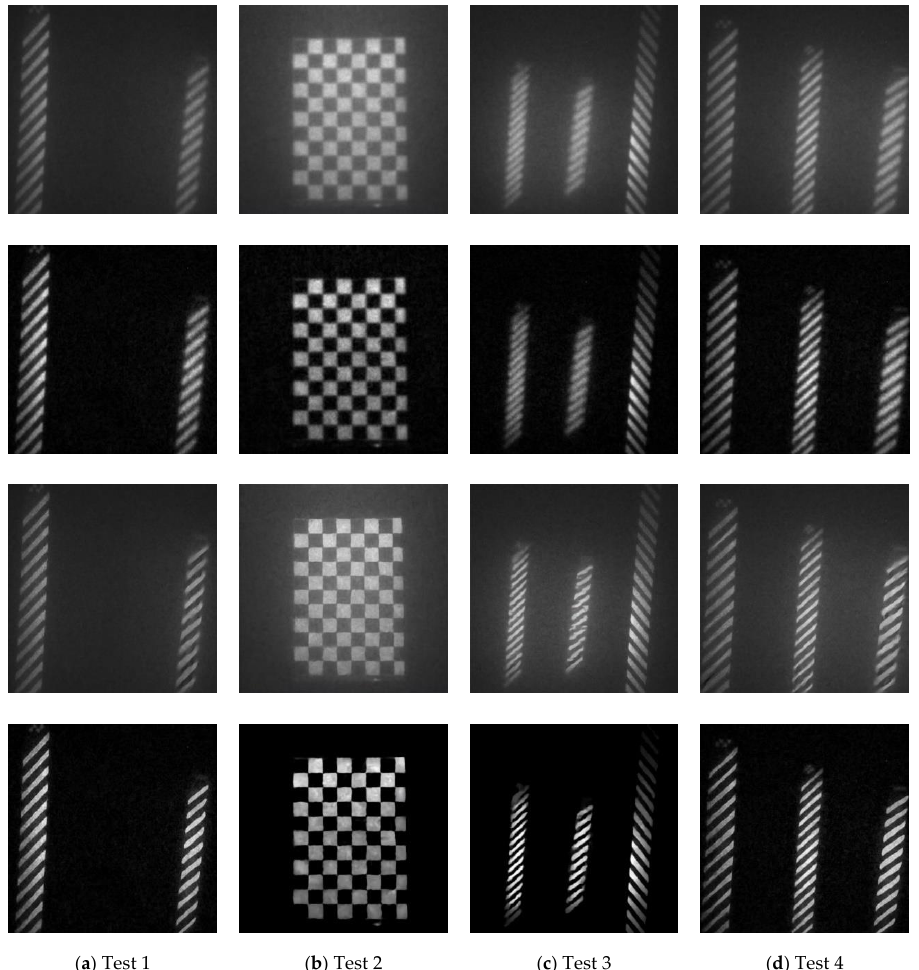
Figure 10. Image deblurring results. The first row is the original data (denoted by ORI), the second row is the data with the removal of backscattered light (denoted by SUB), the third row is the result of the deblurring of the first row images (denoted by ORI-deblur), and the fourth row is the blur removal result for the second row images (denoted by SUB-deblur).